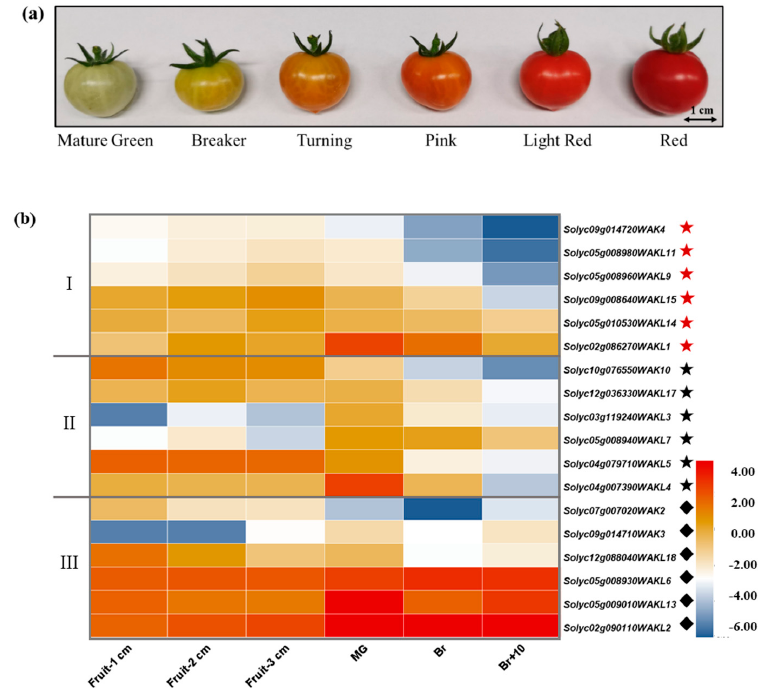
Figure 6. Expression analysis of SlWAK-RLKs across different fruit development stages. ( a ) Tomato fruits of different stages used in the experiment; ( b ) Expression analysis of SlWAK-RLK genes in various tomato fruit development stages. The RNA-seq expression data (Tomato Genome Consortium, 2012) of various stages were used to reconstruct expression patterns of SlWAK-RLK genes in tomato cultivar Heinz. Excluding the RPKM 0 in any organs and stage. Relative expression values were transformed to log 2 (RPKM) represent relative expression levels. MG, mature green stage; B, breaker stage; B10, 10 days post-breaker. Icon on the right side of gene names indicate specific expressed genes.